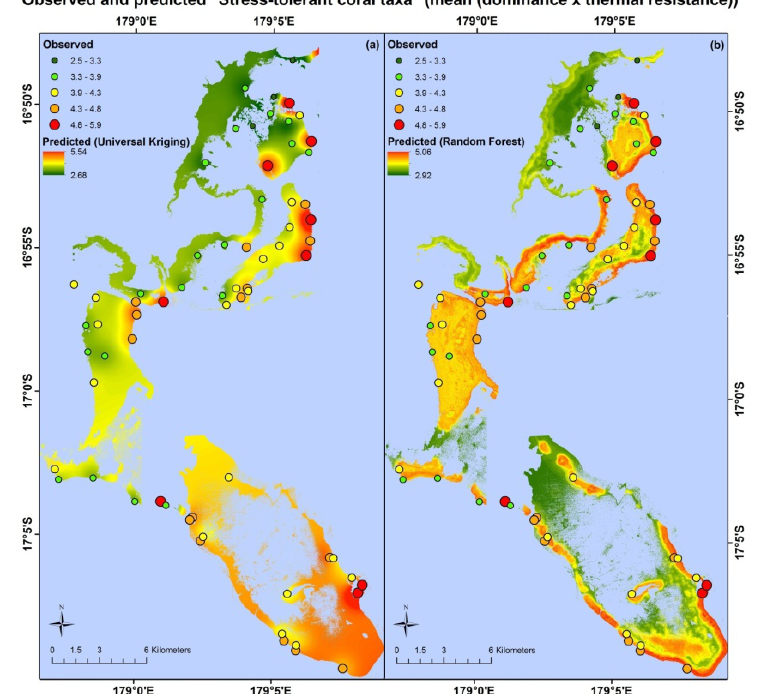
Figure 5. Observed and predicted values of “stress-tolerant coral taxa” for the study area. ( a ) Predictions based on the Universal Kriging model. ( b ) Predictions based on the Random Forest